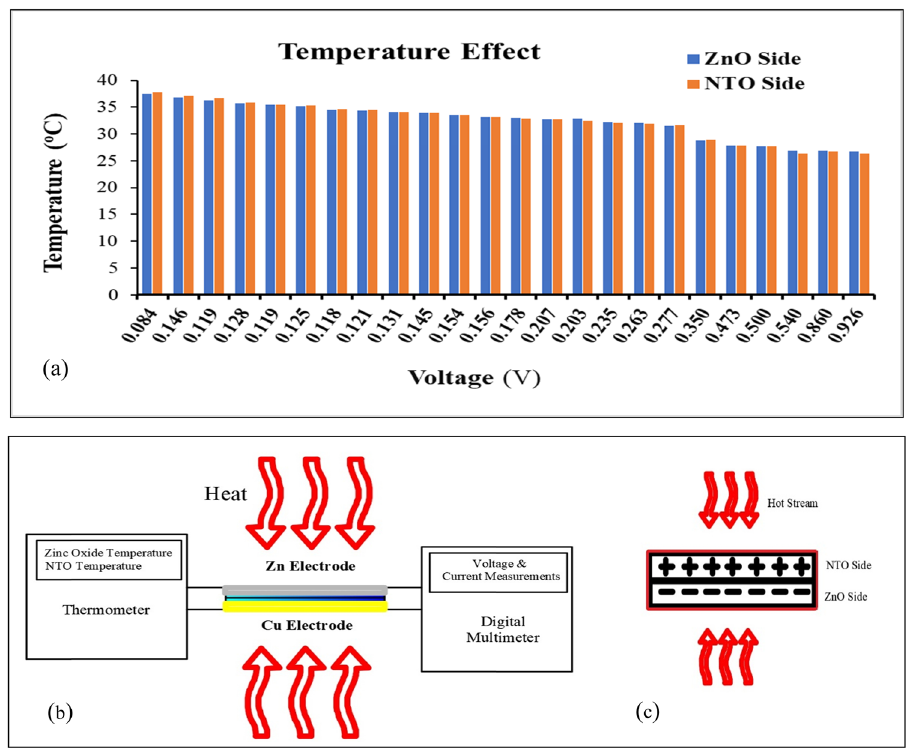
Figure 14: Pyroelectric property of ZnO NSs – NTO: ( a ) temperature versus voltage at low temperature di ff erence ( 0.1 – 0.3°C ) . ( b ) Schematic diagram of experiment setup. ( c ) Signal recti fi cation in ZnO NSs –